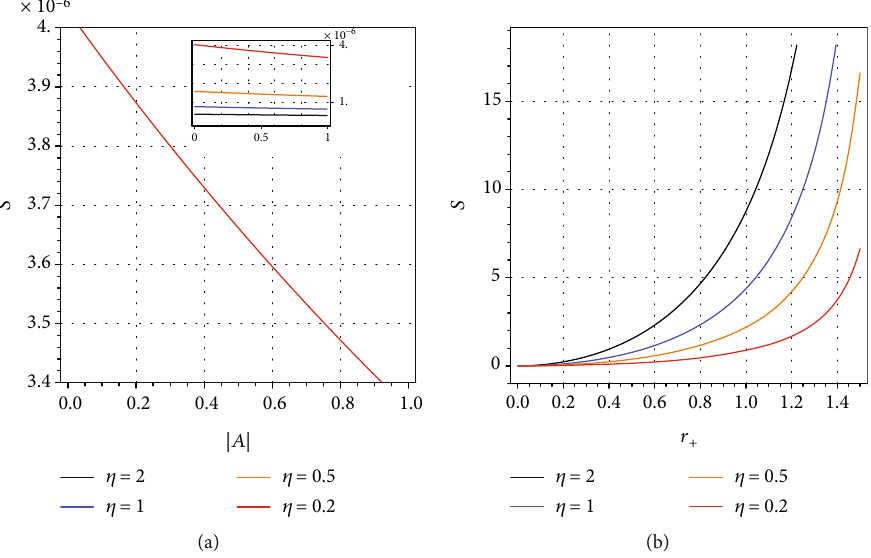
Figure 1: (a) The entropy of the charged accelerating AdS Black hole with respect to the acceleration parameter A . Here, we take q = 0 : 01 , = 0 : 190382 given by Eq. (A.1). (b) The entropy of the charged accelerating AdS Black hole in terms of the m = 0 : 1 , ℓ = 1 , η = 0 : 2 , and r + within di ff erent values of accelerating parameter A . Here, we take q = 0 : 01 , m = 0 : 1 , and ℓ = 1 horizon radius r +